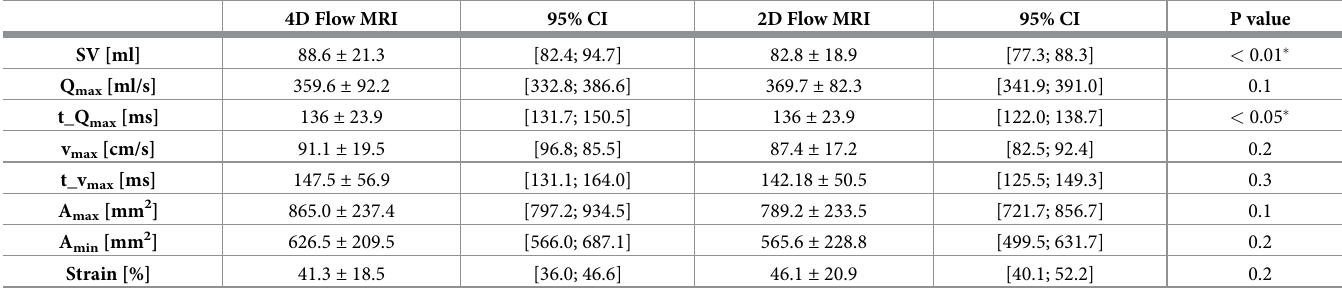
mean bias compared to 4D Flow MRI of 5.5 ± 17.2 ml. Phantom correction further improved mean bias to 3.1 ± 12.3 ml (4D Flow vs. 2D Flow MRI) and to -0.1 ± 20ml (4D Flow MRI vs. CINE-bSSFP), decreasing the Bland-Altman window width, too. Similar to volumes, the peak velocity revealed good agreement between 2D Flow and 4D Flow MRI of 89.4 ± 14.9 cm/s and 93.3 ± 16.3 cm/s. Bland Altman analysis demonstrated a mean bias of 3.9 ± 12.5 cm/s which was further improved by phantom correction to 1.3 ± 14.5 cm/s. Table 3. Comparison of hemodynamic and anatomical values between 2D and 4D Flow MRI in the entire study